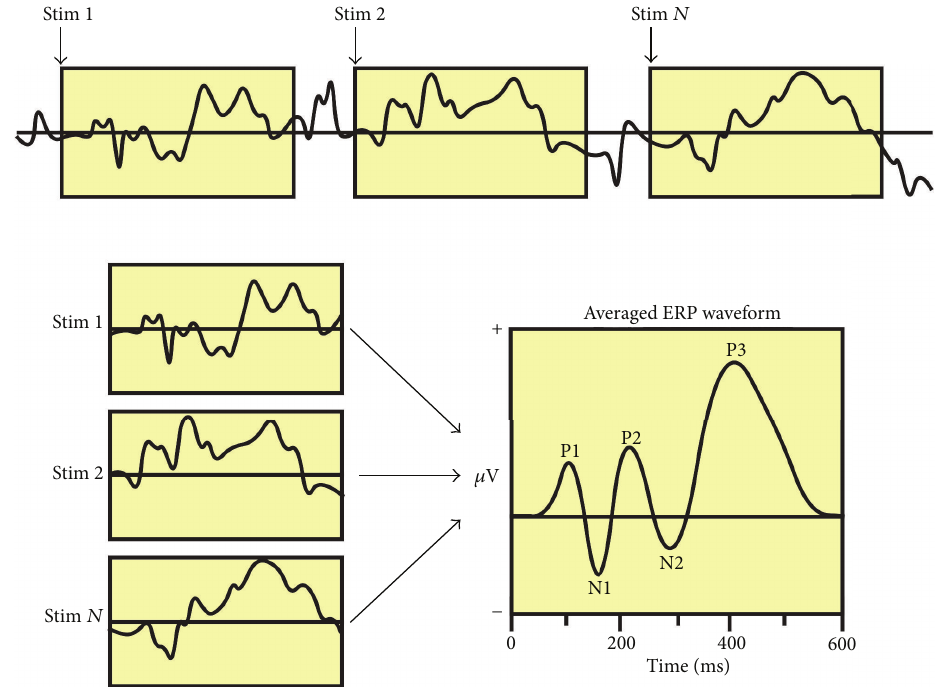
Figure 3: The event-related potential (ERP) technique. A raw EEG record is punctuated by the delivery of stimulus events ( Stim 1, Stim 2, ..., Stim 𝑁) to the subject. The EEG data for each event-related window is then averaged to produce the ERP, which can exhibit several positive (e.g., P1) and negative (e.g., N1) components. Individual ERP components are thought to reflect various aspects of cortical processing. Using this method in adults during REM sleep—with individual twitches as the events while recording from a somatotopicallyrelatedregionofcortex—twitch-relatedspindleburstswithintheactivatedEEGmayberevealed.Figureusedwithpermission of Steven J.